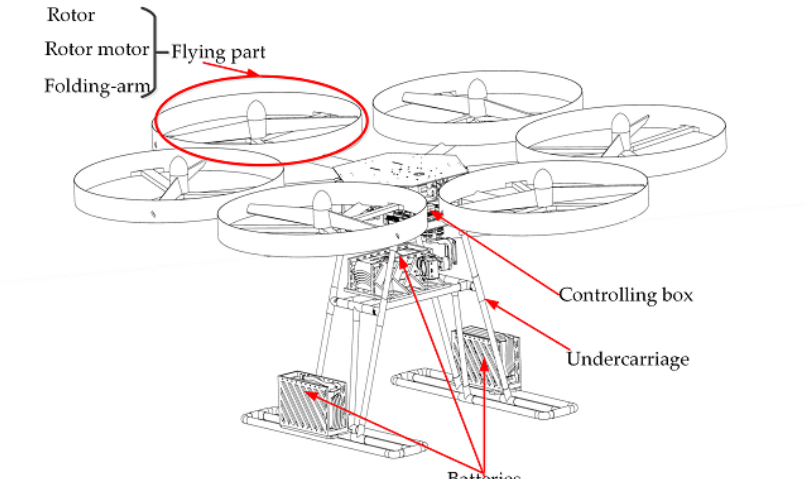
Figure 4. Schematic diagram of the flying mechanism.